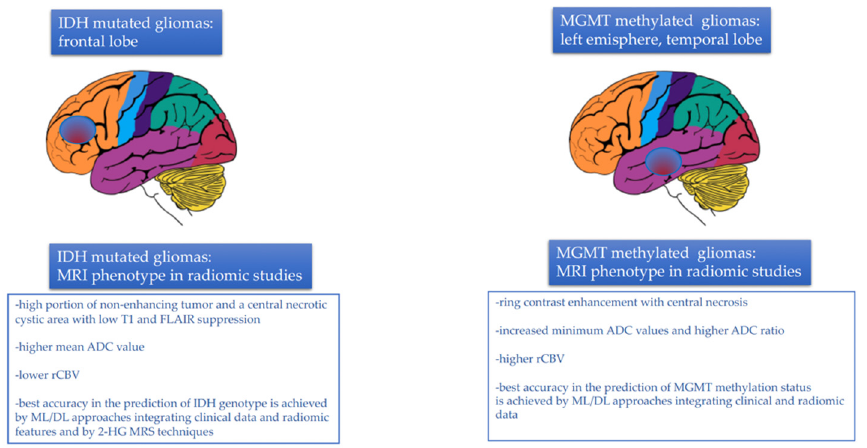
Figure 3. MRI tumor phenotype in relation to IDH mutational status and MGMT methylation status assessed by radiomic studies.